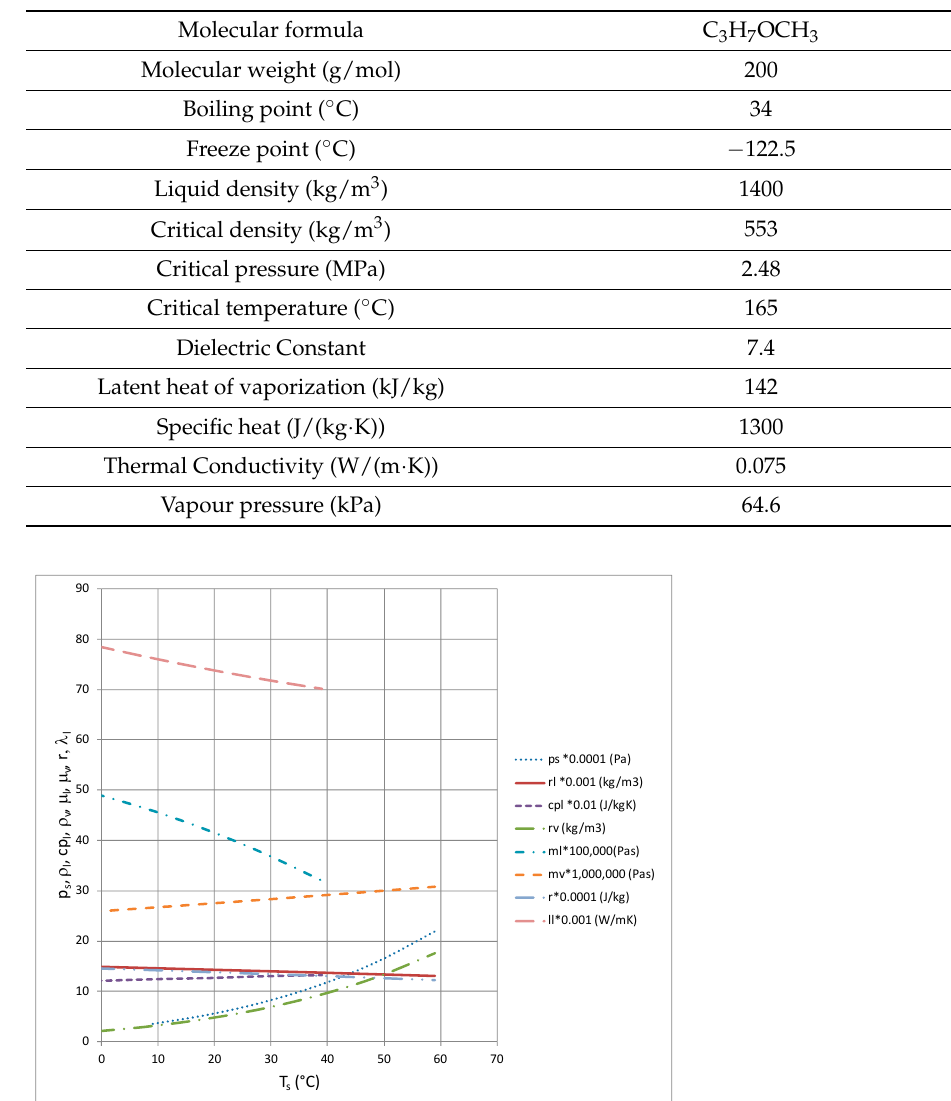
Figure 3. The tested stainless steel minichannels. Table 1. Physical properties of HFE 7000 refrigerant for working temperature 25 ◦ C [17].